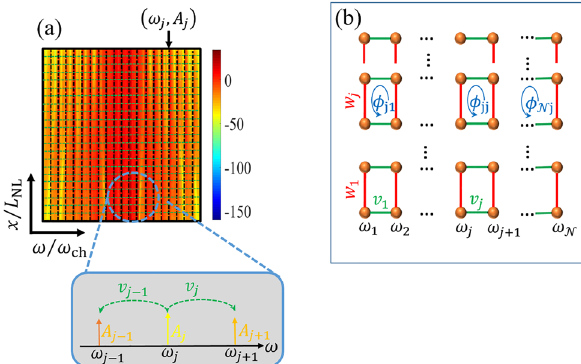
Figure 4: Mapping between the stable FCs to a synthetic dimension: panel (a) represents the power spectrum of the spectral harmonic < x < − 4 L and − 5 . 5 L correspond to side-bands for | 𝜔 | < 2 𝜔 ch NL NL robust propagation of FCs. The inset of this figure represents the correlation between the FCs. Panel (b) is the qualitative description of the synthetic lattice corresponding to frequency comb